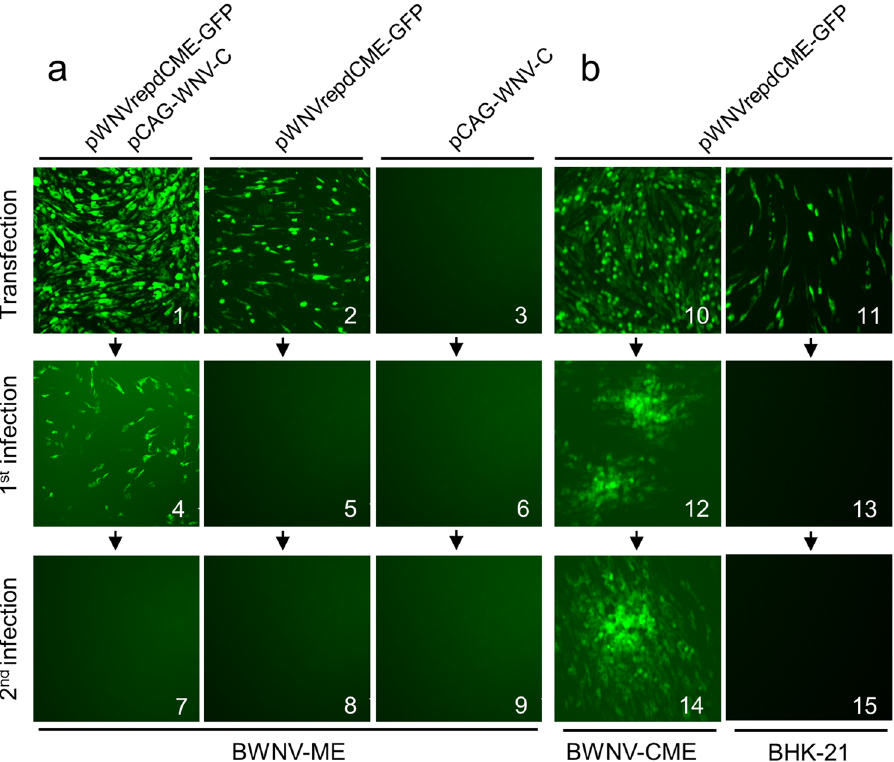
Figure 3. Production of RRPs from the WNV replicon plasmid by transfecting ( a ) BWNV-ME and ( b ) BWNV-CME cell lines. Green florescence was visualized when the replicon plasmid pWNVrepdCME-GFP was transfected into BWNV-ME cells (2), BHK-21 cells (11), BWNV-CME cells (10) or BWNV-ME cells together with the pCAG-WNV-C plasmid (1). The transfected cell supernatants were passaged onto fresh cell cultures as indicated by the arrows, and green florescence was observed only in the cells labelled 4 and 12. Three days post- inoculation, the supernatants of the cells infected first were used to inoculate the cells as indicated by the arrows for a second infection. Green florescence was analysed 72 h